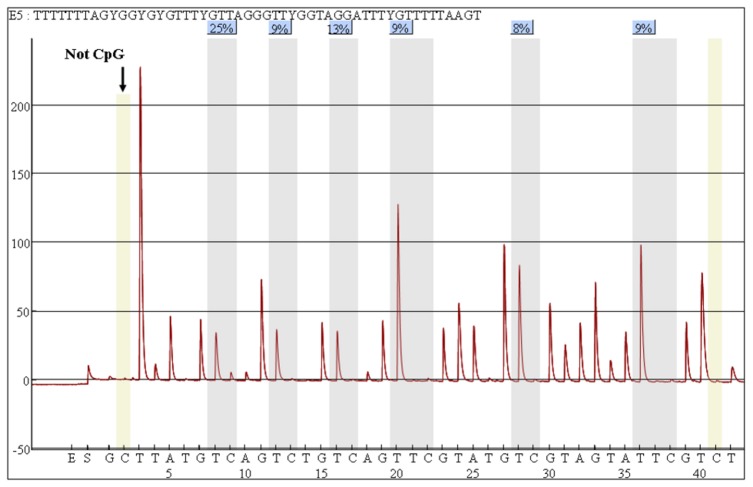
Pyrosequencing assay used to measure Klotho promoter methylation.Methylation level is 12.17% in the renal tissue of a chronic kidney disease patient. The percentage (%) (grey) is the proportion of cytosine at each CpG site after bisulfite conversion, and the methylation level of each CpG site is estimated by the proportion of cytosine (%). The overall Klotho methylation level is calculated as the average of the proportions of cytosine (%) at the 6 CpG sites. Arrows indicate no residual cytosine at the non-CpG site, ensuring complete bisulfite conversion.